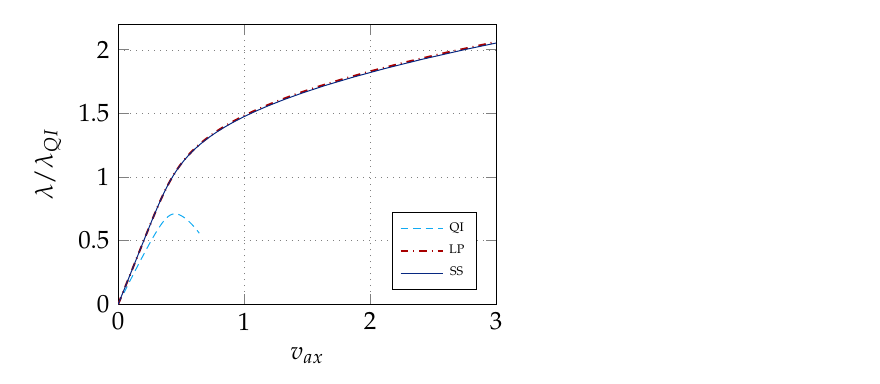
Figure 9. Load-axial displacement v ax paths for the baseline QI case, the optimal distribution of lamination parameters (LP, 9 9 elements) and the fibre orientations retrieved in stage 2 (SS). × 9 control points for the Table 1. Results of the optimised material design LP for a grid of 9 × lamination parameters and for the retrieved fibre orientations (SS).